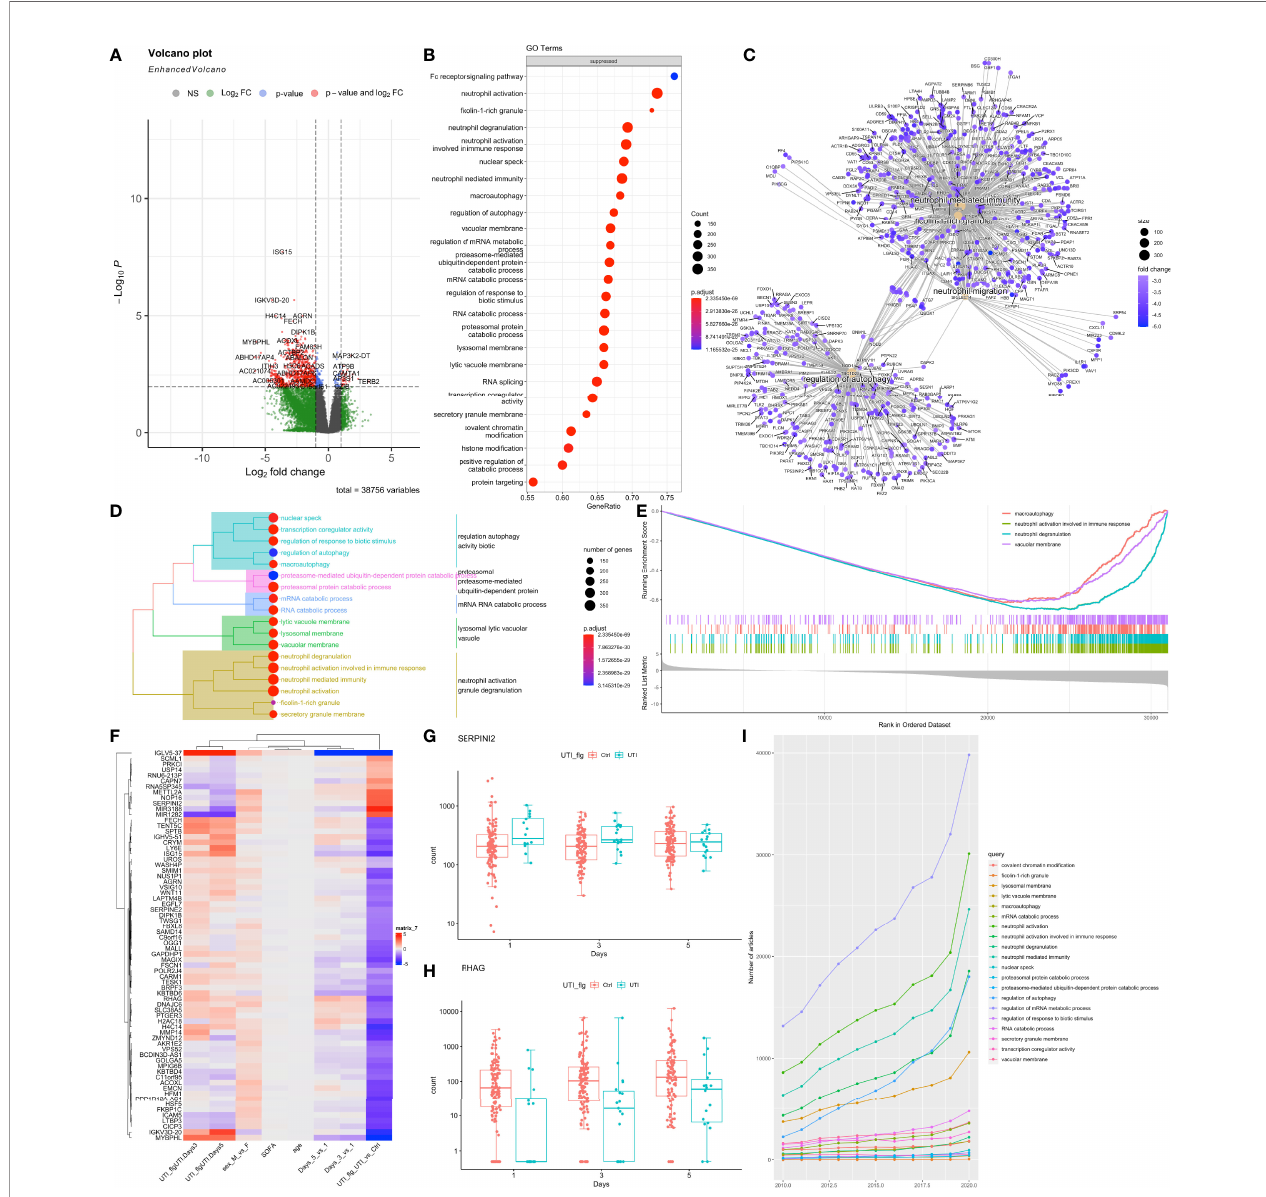
FIGURE 2 | Differential gene expression analysis of bulk RNA-seq data. (A) Volcano plot showing the differentially expressed genes between UTI and control samples, while adjusting for SOFA, age, sex and days. P values were adjusted for multiple comparisons. Genes with adjusted p < 0.01 and log2 fold change > 1 were labelled. (B) gene set enrichment analysis of suppressed genes for GO terms. (C) network visualization of enriched terms and associated genes. (D) tree plot showing the hierarchical clustering of enriched terms by using Jaccard ’ s similarity index. (E) The GSEA enrichment score for several sample pathways. The running sum deviated in the negative direction suggesting suppressed pathways. (F) Heatmap showing the coef fi cient matrix of the negative binomial regression model, with an interaction term between days and UTI. Top 70 genes of the largest absolute values of coef fi cients were displayed. (G, H) Example genes with signi fi cant interaction effects between days and UTI groups are displayed with box plots. (I) publication trends of the top enriched terms extracted from PubMed search